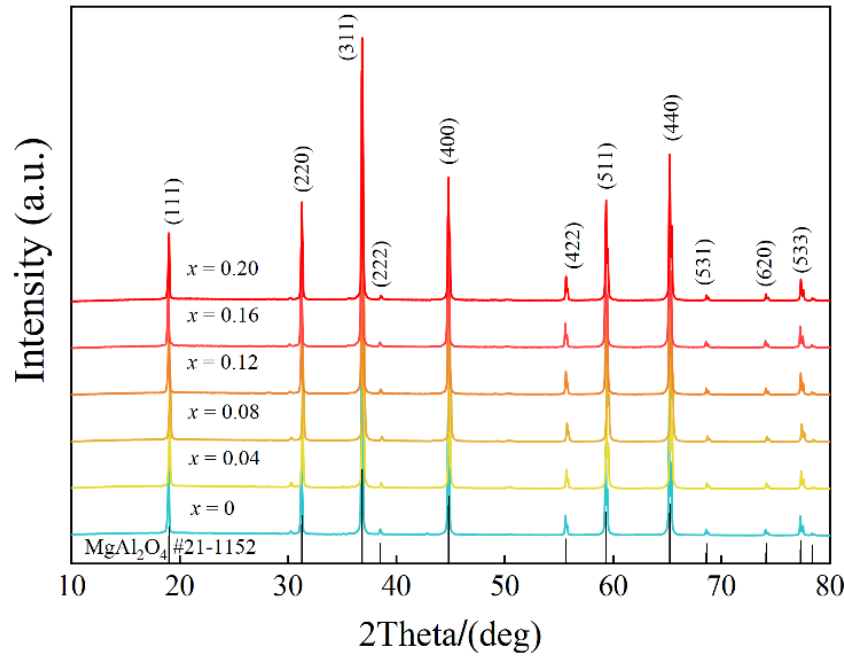
Figure 2. The XRD patterns of the Mg 1 − x Cu x Al 2 O 4 ceramics.